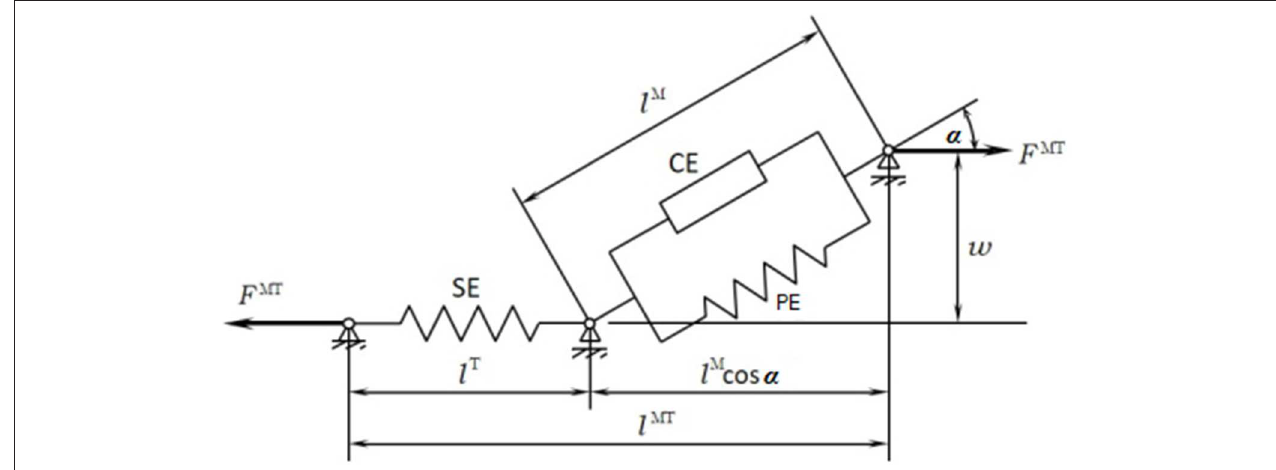
FIGURE 4 | Hill’s muscle